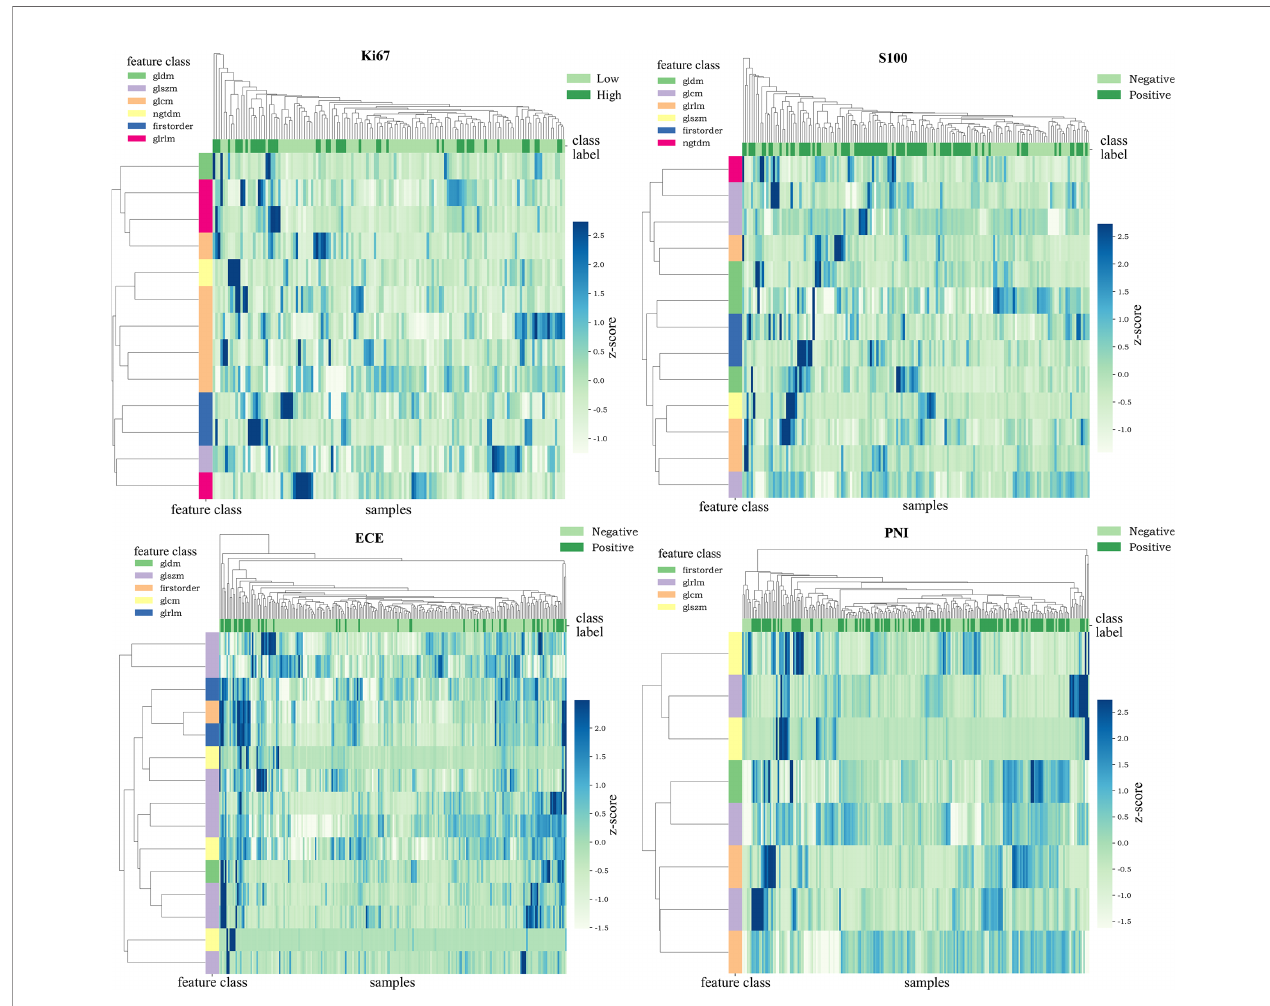
FIGURE 3 | Heat maps of the selected features. The color of the maps represented the value of the selected features. The color of positive cases or high Ki67 expression cases was generally darker. This proved the ability of the features themselves to distinguish the biological characteristics of